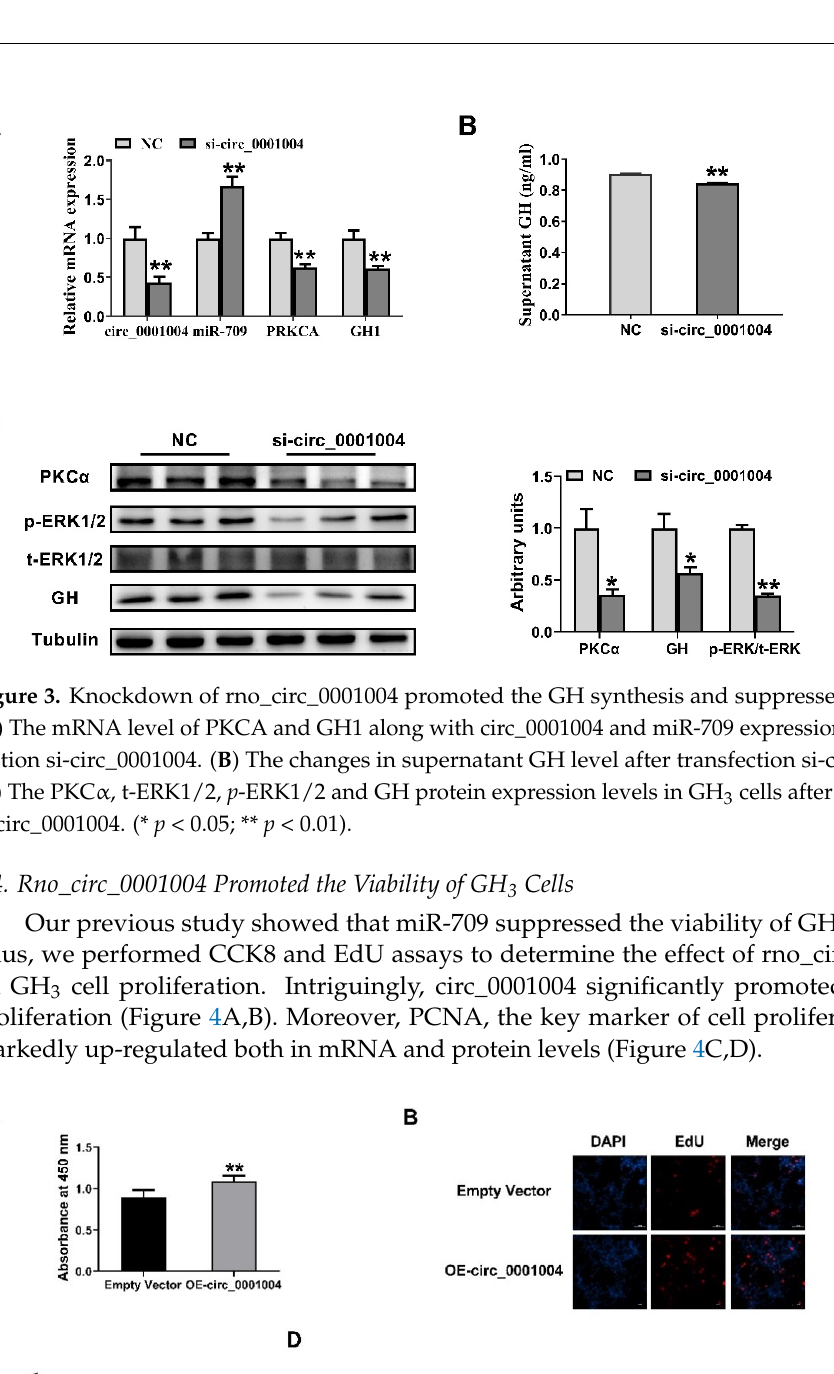
Figure 5. Effects of rno_circ_0001004 in reversing the inhibition of cell proliferation by miR ‐ 709. ( A ) The GH 3 proliferation was evaluated with CCK ‐ 8 kits. ( B ) EdU ‐ positive cells. ( C ) PCNA mRNA